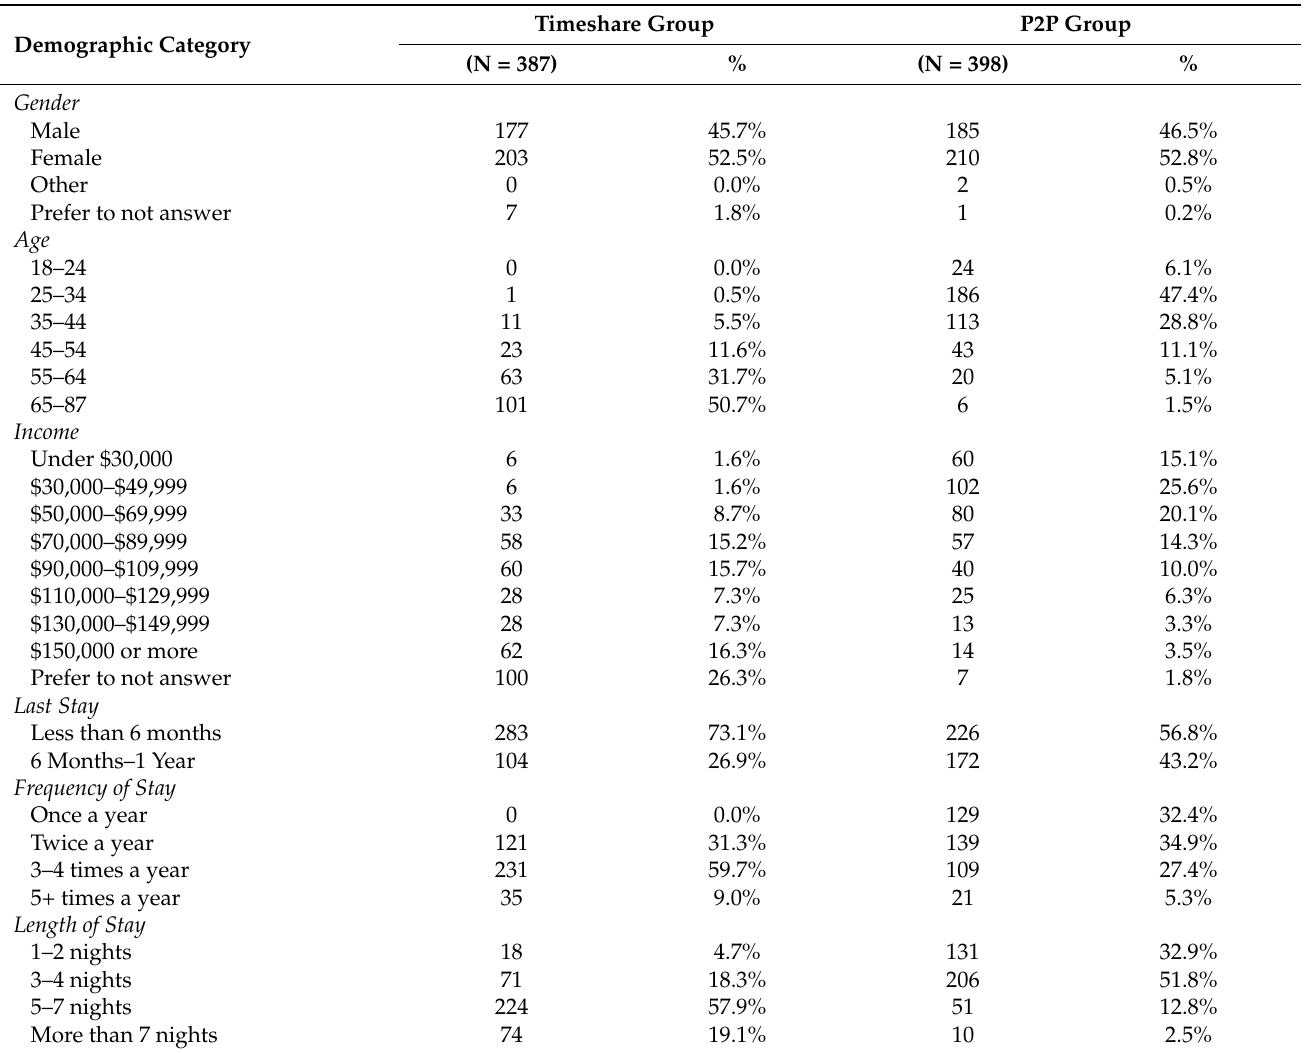
Table 1. Respondent